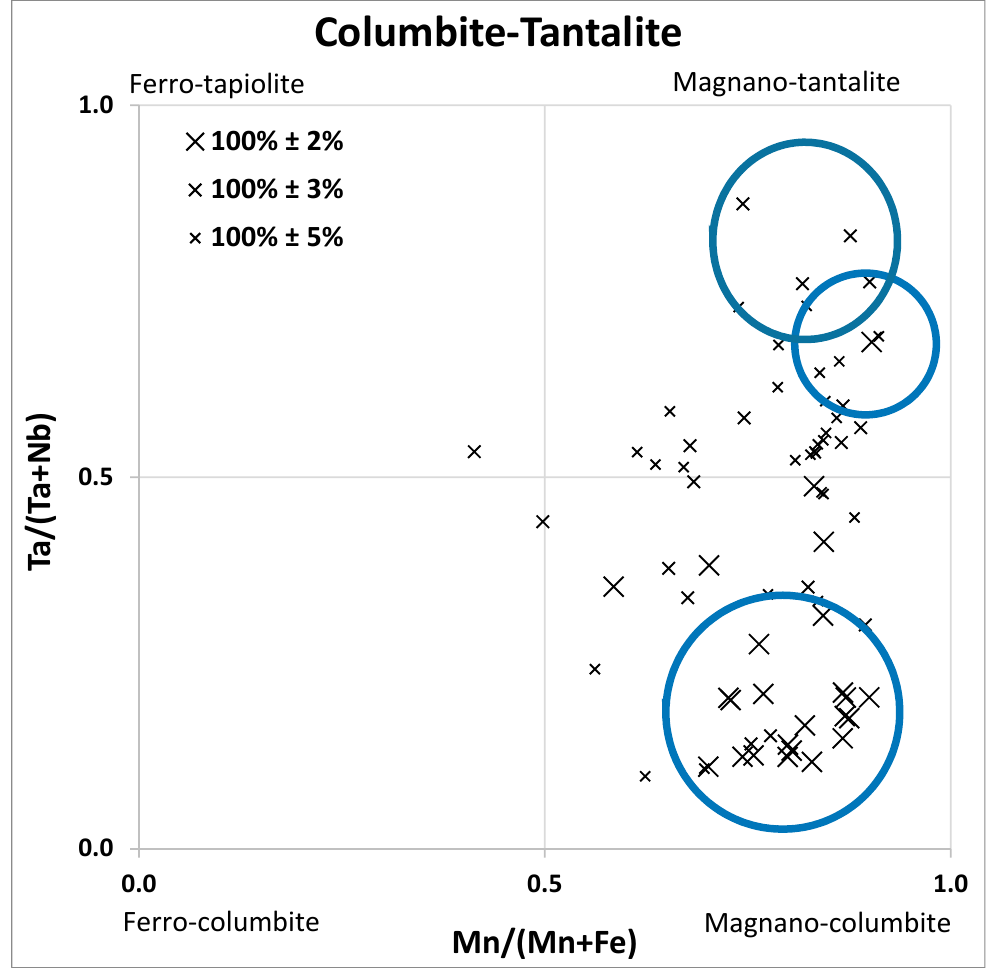
Figure 10. Quadrilateral plot of columbite-tantalite elemental composition. Plotted based on normalised moles of cations.